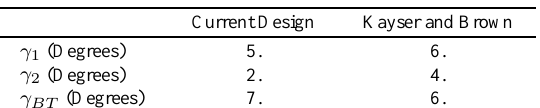
Table 1 Hinge and boattail angles Current